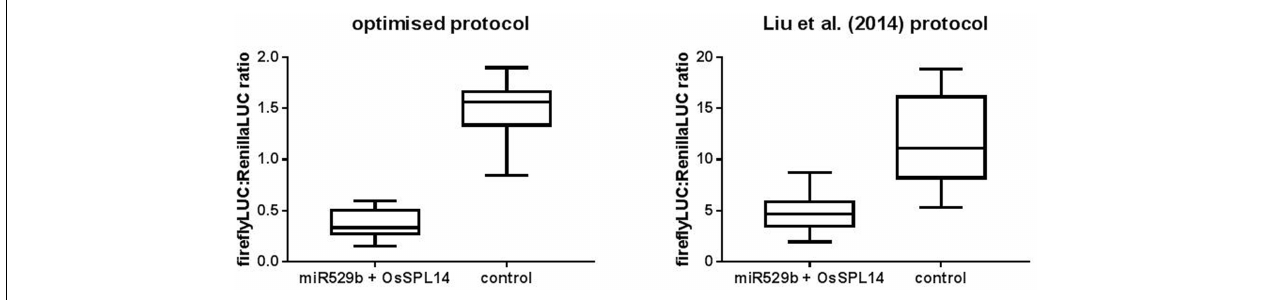
FIGURE 7 | Comparison of the optimized dual LUC assay versus the prior art described by Liu et al. (2014). The optimized assay conditions include using pGrDL_SPb for OsSPL14 target sequence cloning, a 10:1 ratio of rice miR529b precursor culture to target plasmid culture, 3 days incubation post-agroinfiltration of N. benthamiana leaves, and dual LUC assays on extracts diluted 20-fold. The optimized assay control consists of assays where the miR529b precursor culture was replaced with a precursor construct culture that does not target OsSPL14 sequence. The Liu et al. (2014) assay conditions include using pGreen dualLUC 3 (cid:48) UTR sensor plasmid for OsSPL14 target sequence cloning, a 1:1 ratio of rice miR529b precursor culture to target plasmid culture, 2 days incubation post-agroinfiltration of N. benthamiana leaves, and dual LUC assays on undiluted extracts. The Liu et al. (2014) control consists of assays where the OsSPL14 target plasmid culture was replaced with a plasmid culture that is not targeted by rice mir529b. The results are depicted as box and whisker plots, with interquartile range boxes and min/max whiskers ( n =